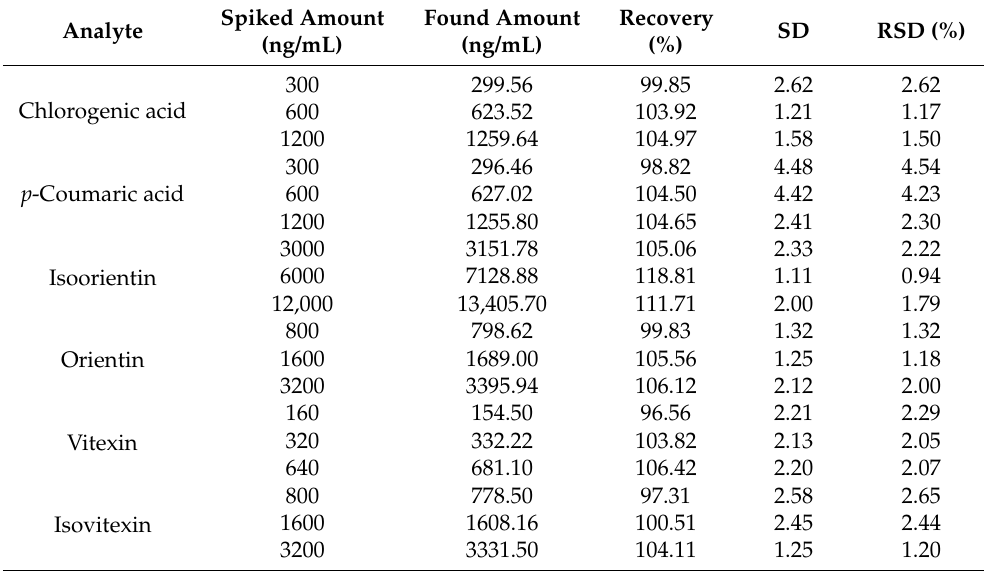
Table 7. Extract recovery tests for 6 marker components in P. pubescens leaves.